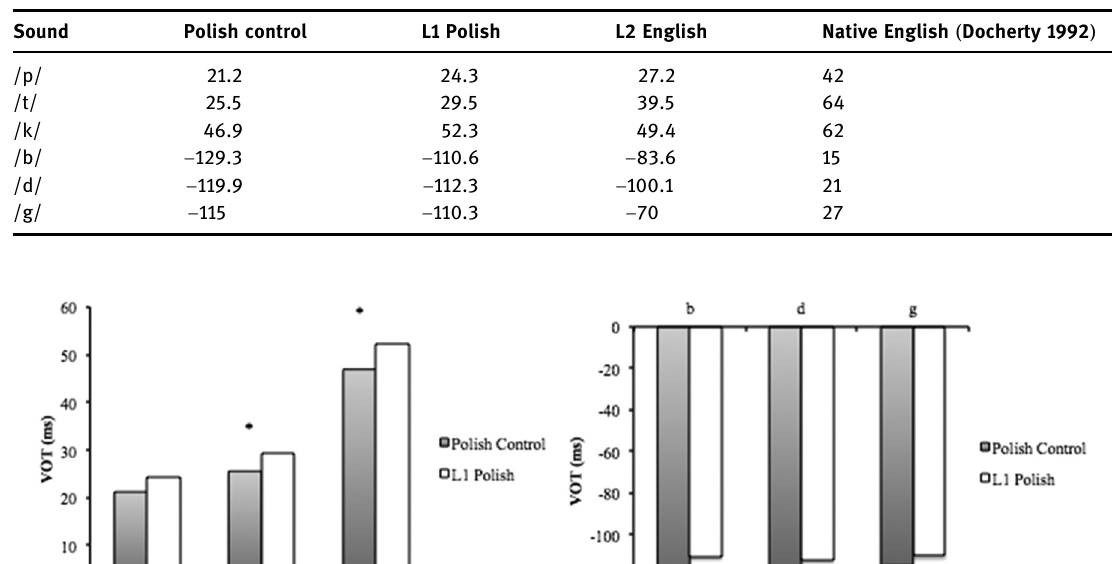
Table 3: Mean results of VOT in ms for L1 Polish compared to Polish control